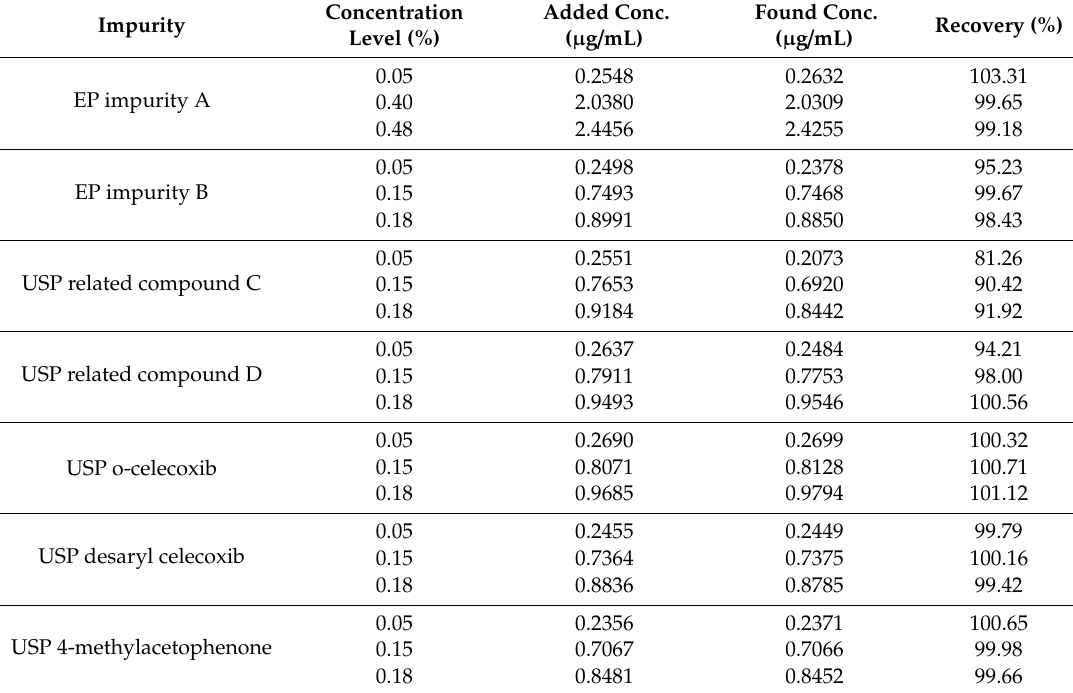
Table 5. Results of recoveries at three concentration levels of investigated impurities of